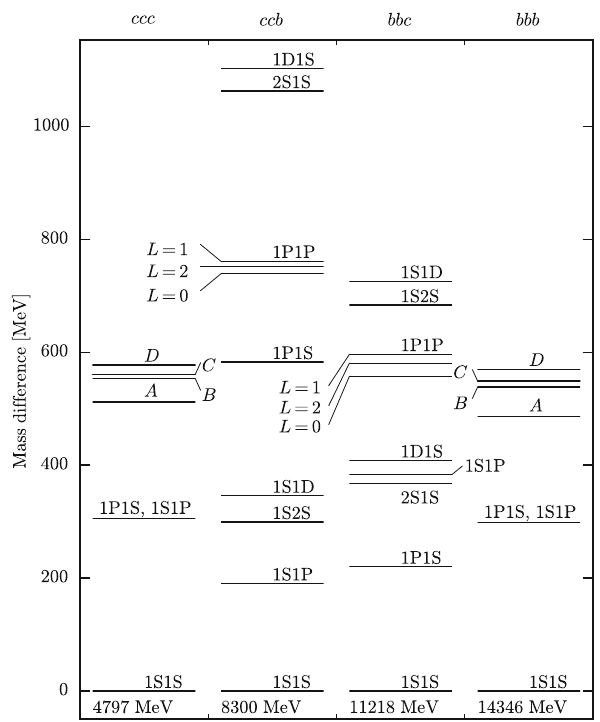
Fig. 4 Qualitative picture of triply heavy baryon mass spectrum impliedbythesecond-orderRGPEPinheavy-flavorQCDandourgluon massansatz.Thefigureshowsexcitationsabovethegroundstates1 S 1 S , whose absolute masses are written at the bottom of each column. The ccb spectrum displays extraordinarily large mass excitation for states 1 P 1 S , 2 S 1 S and 1 D 1 S in ccb . Such high excitations are associated with formation of cc -diquarks, bound by a harmonic force that is strong because the charmed quarks are much lighter than the bottom quarks. Much less pronounced splittings appear in the bbc baryons. See the text for further discussion